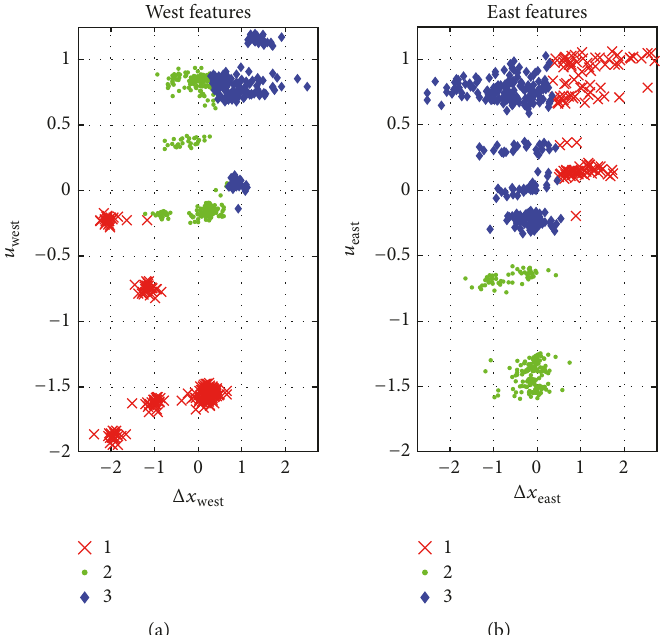
Figure 5: Clustering of the training data using 𝐾 -means algorithm.